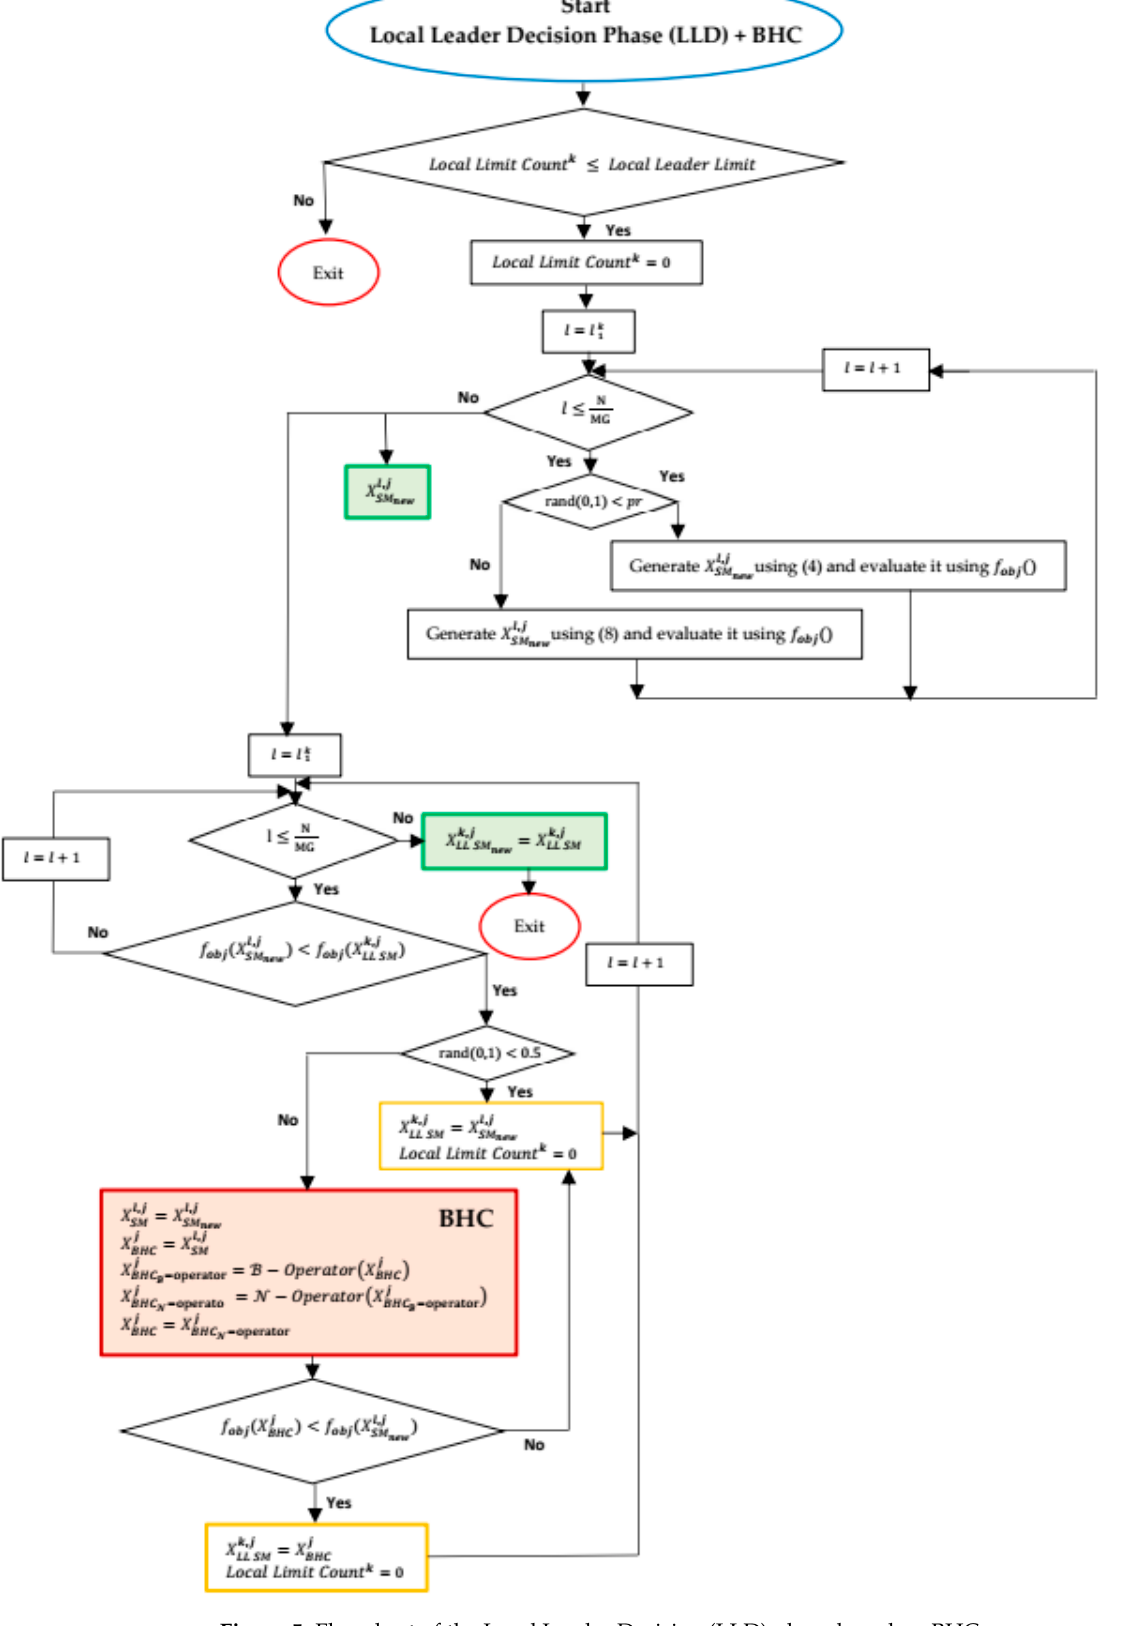
Figure 5. Flowchart of the Local Leader Decision (LLD) phase based on BHC.